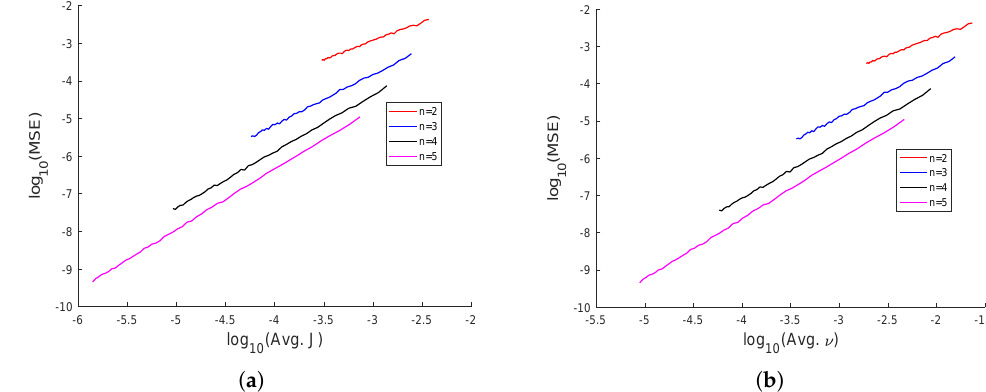
Figure 17. log (MSE) vs. logarithm of Li’s MoN. ( a ) log 10 vs. log (Avg. ν ) using 10 scalar measurements. 10